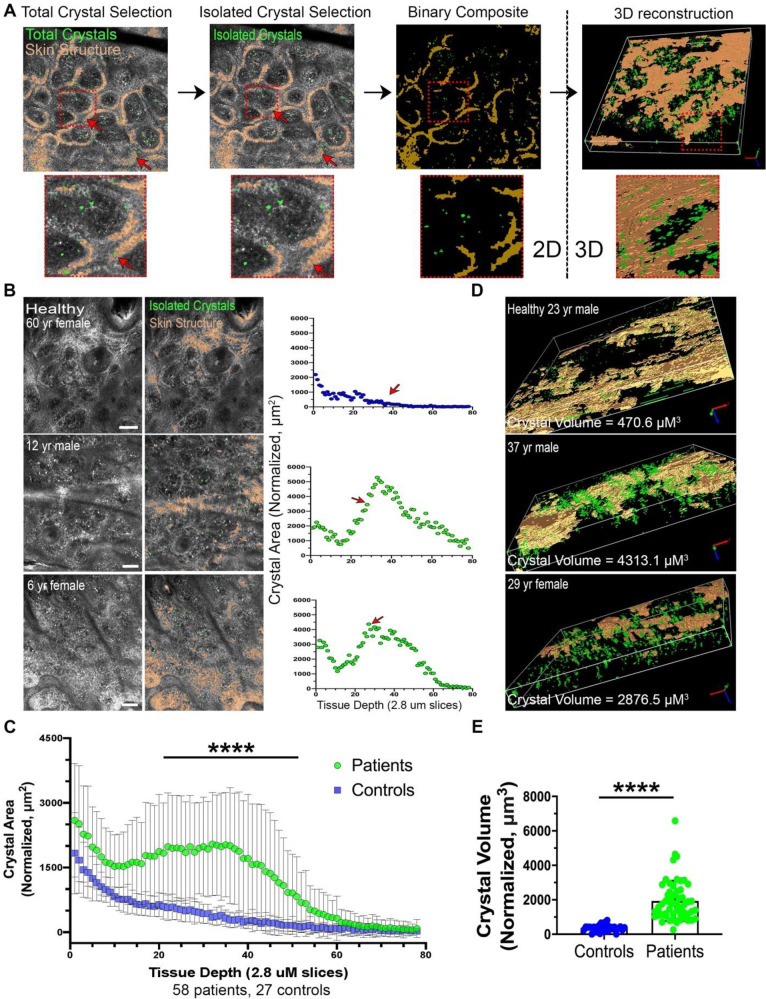
Automated 2D and 3D image analysis detects an increased crystallization in cystinotic skin.A total of 83 image stacks were acquired from 70 cystinosis patients and 38 from 27 healthy controls. A, Workflow from initial selection of total crystals and skin structure to final 3D reconstruction of the papillary dermis region. Arrows indicate false-positive crystals which are eliminated due to overlap with skin structure. Full description of methodology may be found in S1 Fig and Supplementary Methods in (S1 File). B, Representative slices from raw and 2D analyzed intradermal confocal micrographs from a healthy control and patients. XY scatterplot displays the sum of crystal area normalized to total imaged region on the Y-axis vs. tissue depth on X-axis. Arrows indicate which slice is the sample image. C, XY scatterplot depicting mean crystal area +/- SD vs. tissue depth for grouped cystinosis patients vs. healthy controls. For subjects with multiple images, only the most recent encounter was included. Starred region indicates slices where patients have significantly higher crystal area. D, 3D reconstructions of healthy and patient crystal density exclusively in the papillary dermal region due to signal background in epidermis and hypodermis; see Results section “Crystal quantification by automated image analysis in 2D” for details. Representative videos are provided in S3 and S4 Videos. E, Boxplot comparing sum crystal volume in papillary dermis (nCCV) +/- SD between patients and controls. **** = P<0.001. All scale bars = 100 μm.